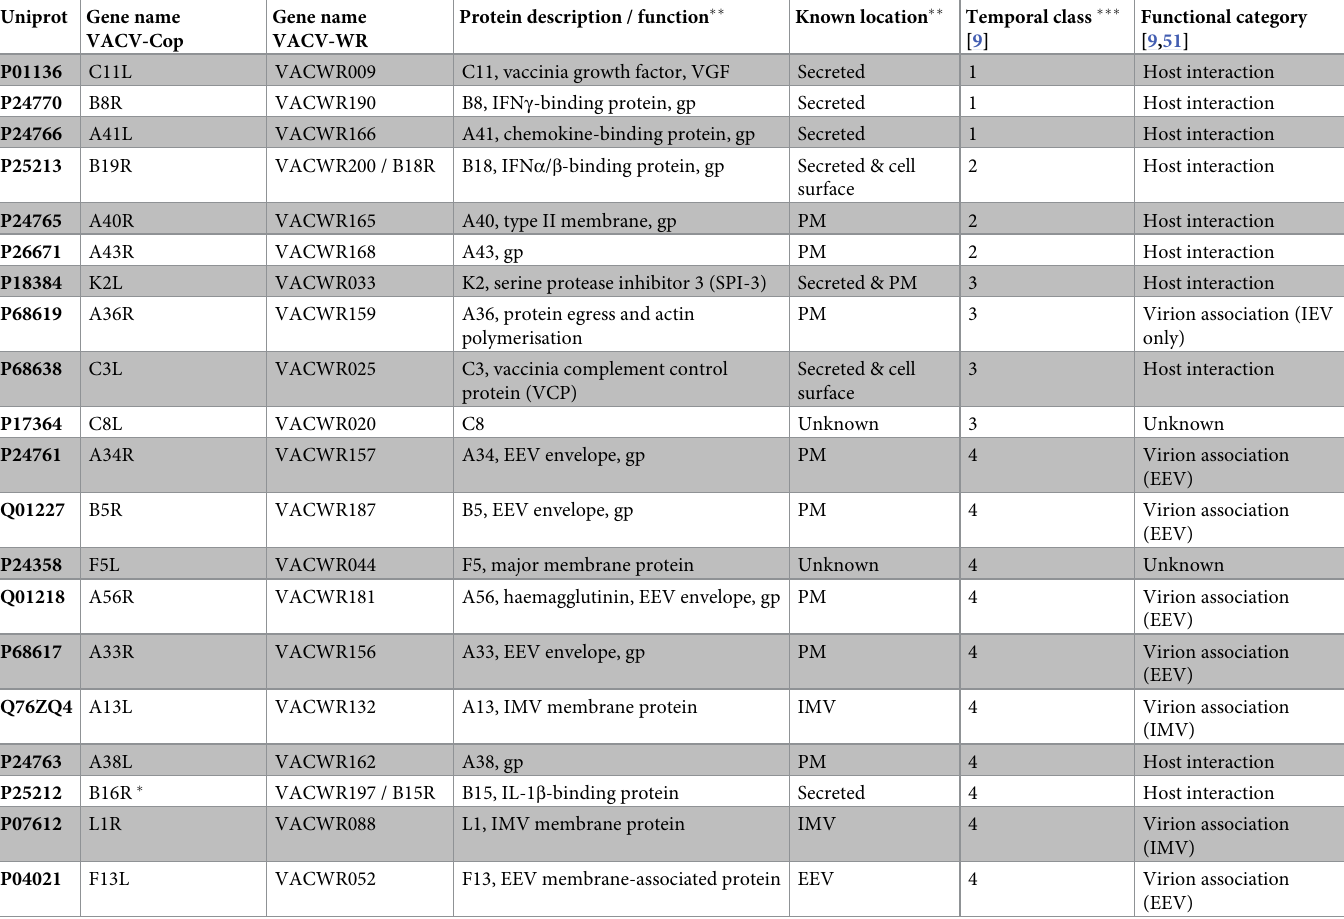
Gene names from VACV strain Copenhagen (Cop) have L or R to indicate direction of transcription. IEV = intracellular enveloped virus. IMV = intracellular mature virus. EEV = extracellular enveloped virus. gp = glycoprotein. � Gene non-functional in VACV strain Copenhagen. �� For a review of VACV protein function and location see [43]. ��� Temporal classes 1 and 2 occur before viral DNA